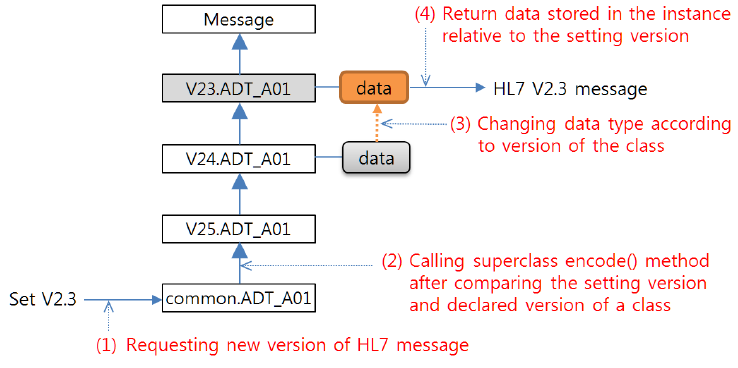
Fig. 7. Encoding procedure of an HL7 message for backward compatibility.